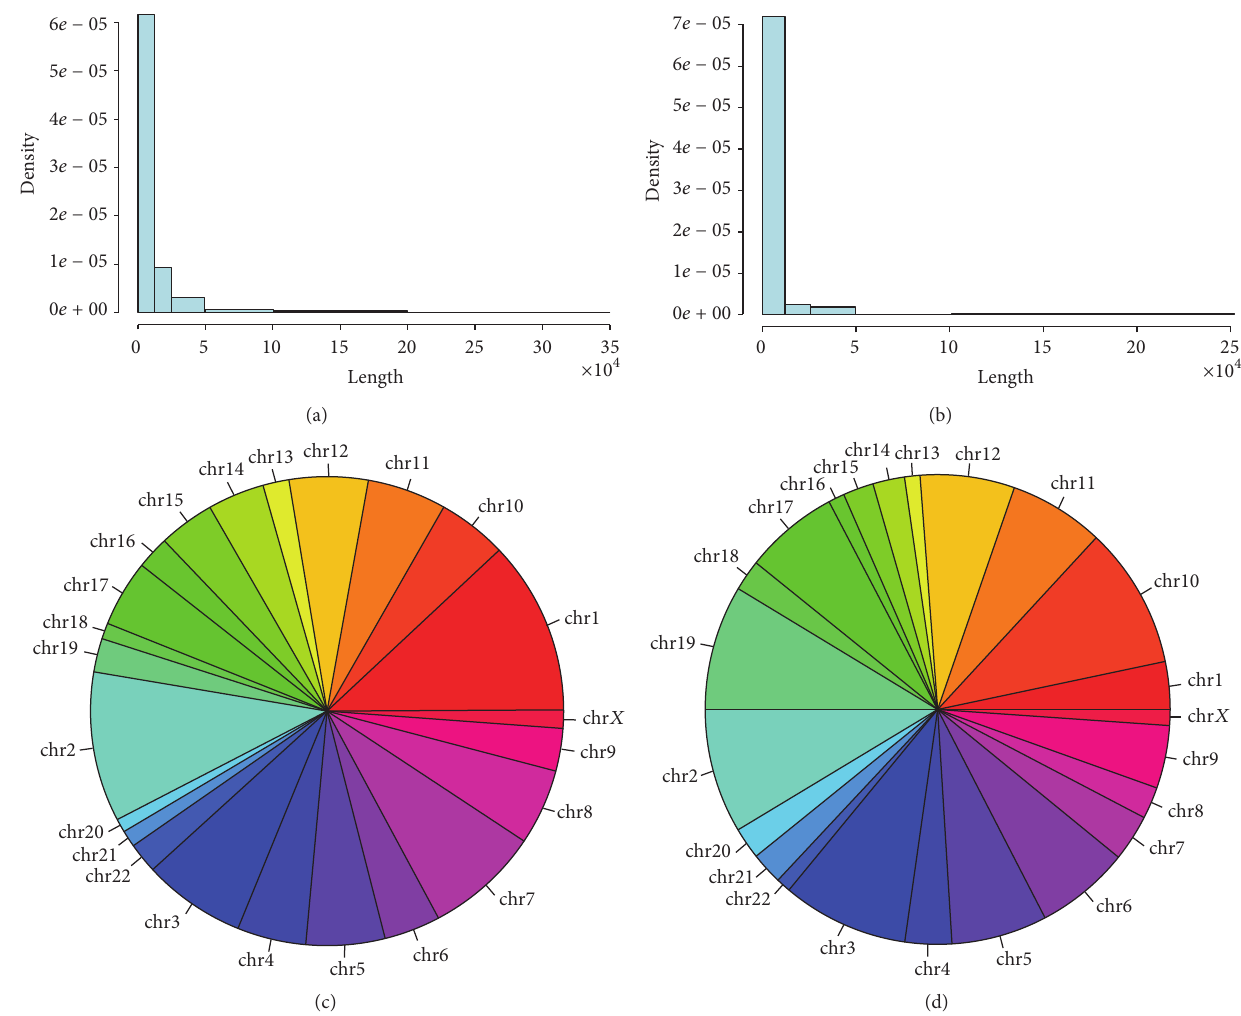
Figure 1: The histograms showed the presence of predicted circRNAs ( 𝑦 -axis ) related to their length ( 𝑥 -axis ) in the totality of DCIS (a) and IDC (b) samples. The pie chart was divided into slices to illustrate numerical proportion of circRNAs predicted for each chromosome in the totality of DCIS (c) and IDC (d)